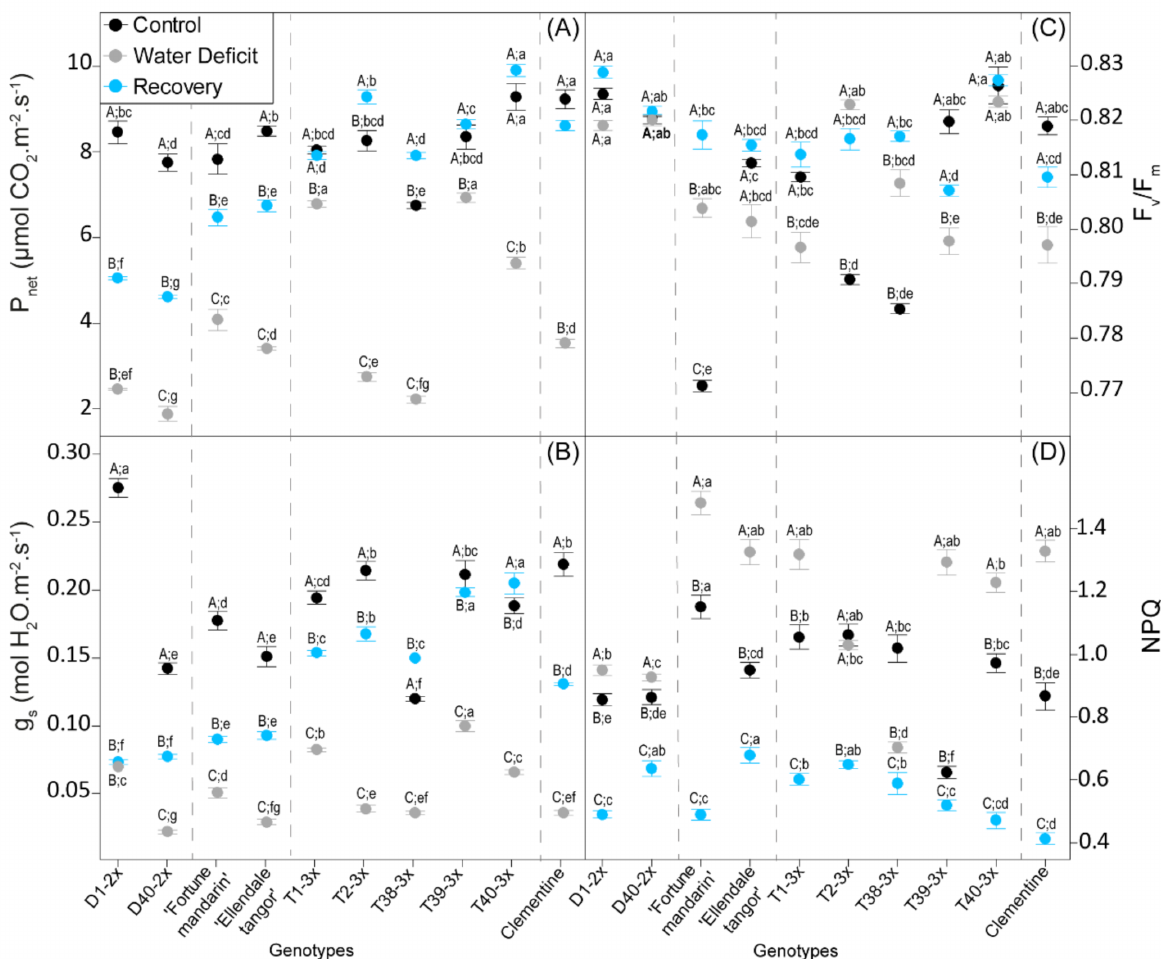
Figure 2. Leaf physiological parameters of 2x and 3x genotypes under three water treatments: 70–100% pot capacity (black point, control), 45–55% pot capacity (grey points, water deficit), and five days after re-watering (blue point, recovery). ( A ) Net photosynthesis ( P net ), ( B ) stomatal conductance ( g s ), ( C ) maximal quantum yield of PSII ( F v /F m ), and ( D ) non-photochemical quenching (NPQ) rate. All data are mean values ( ± S.E.) of 15 independent measurements ( n = 15). Data were analyzed with ANOVA and Fisher’s LSD test ( p < 0.05). Uppercase letters compare water treatments for each genotype. Lowercase letters compare genotype within the same water